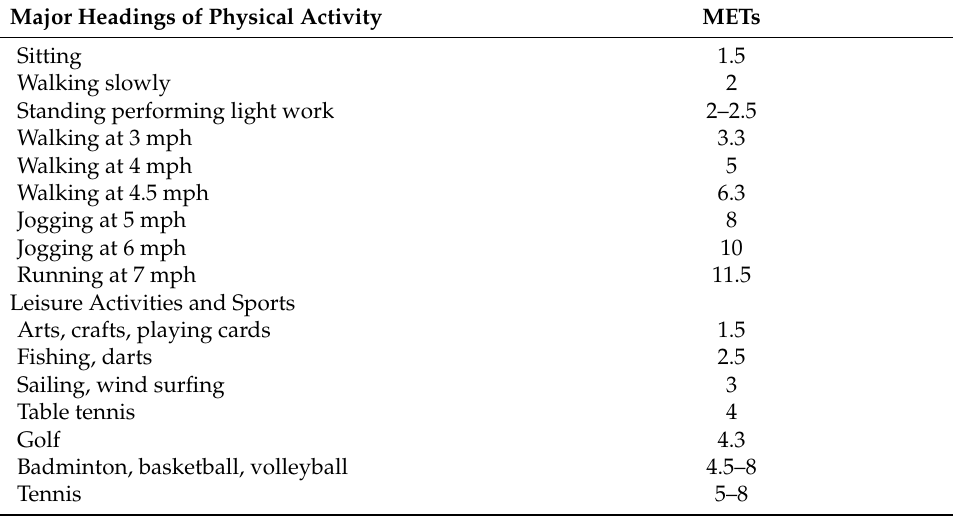
Table 1. Examples of physical activities calculated by metabolic